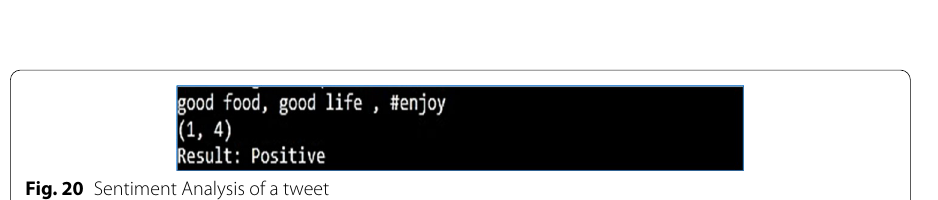
Fig. 20 Sentiment Analysis of a